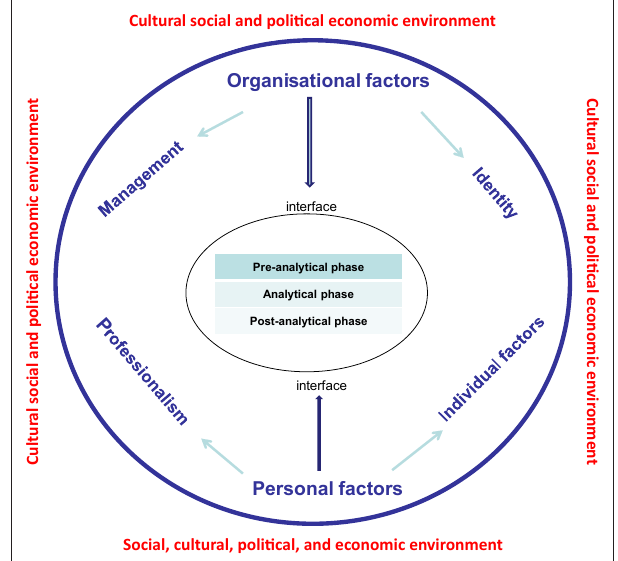
FIGURE 1: Conceptual model of the various factors that shape the interface between clinical and laboratory